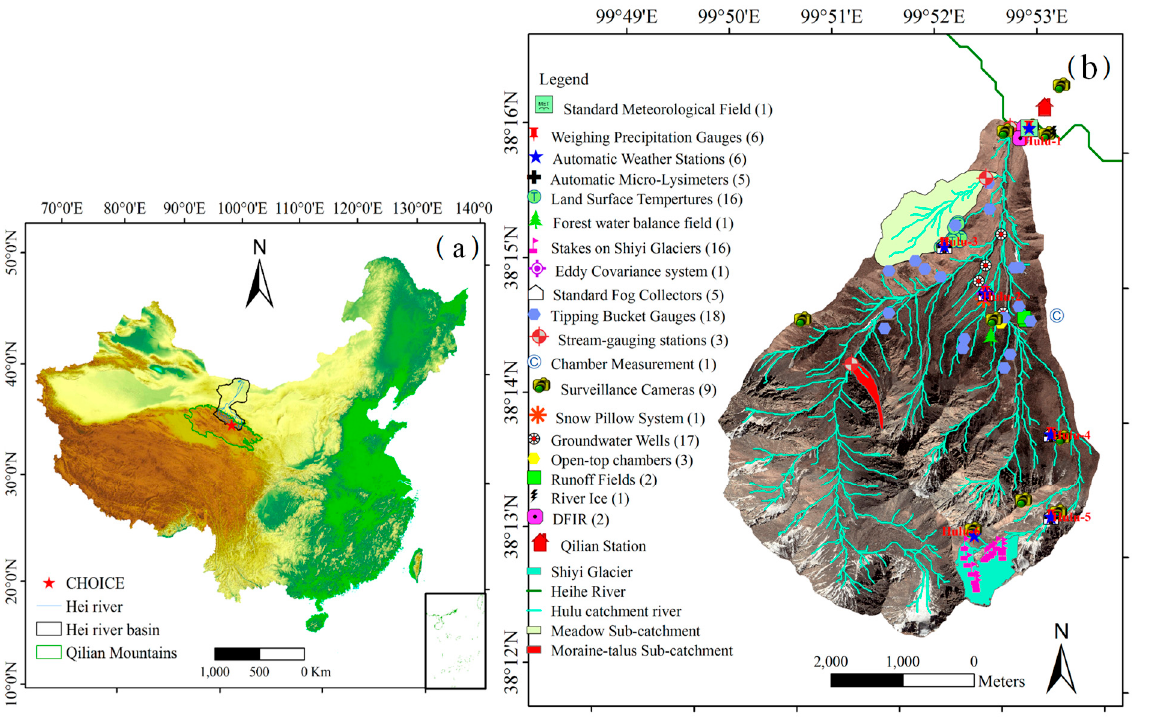
Figure 1. ( a ) The geographical location of Hulu watershed. ( b ) The distribution of instruments and observatories of the Hulu watershed [22].